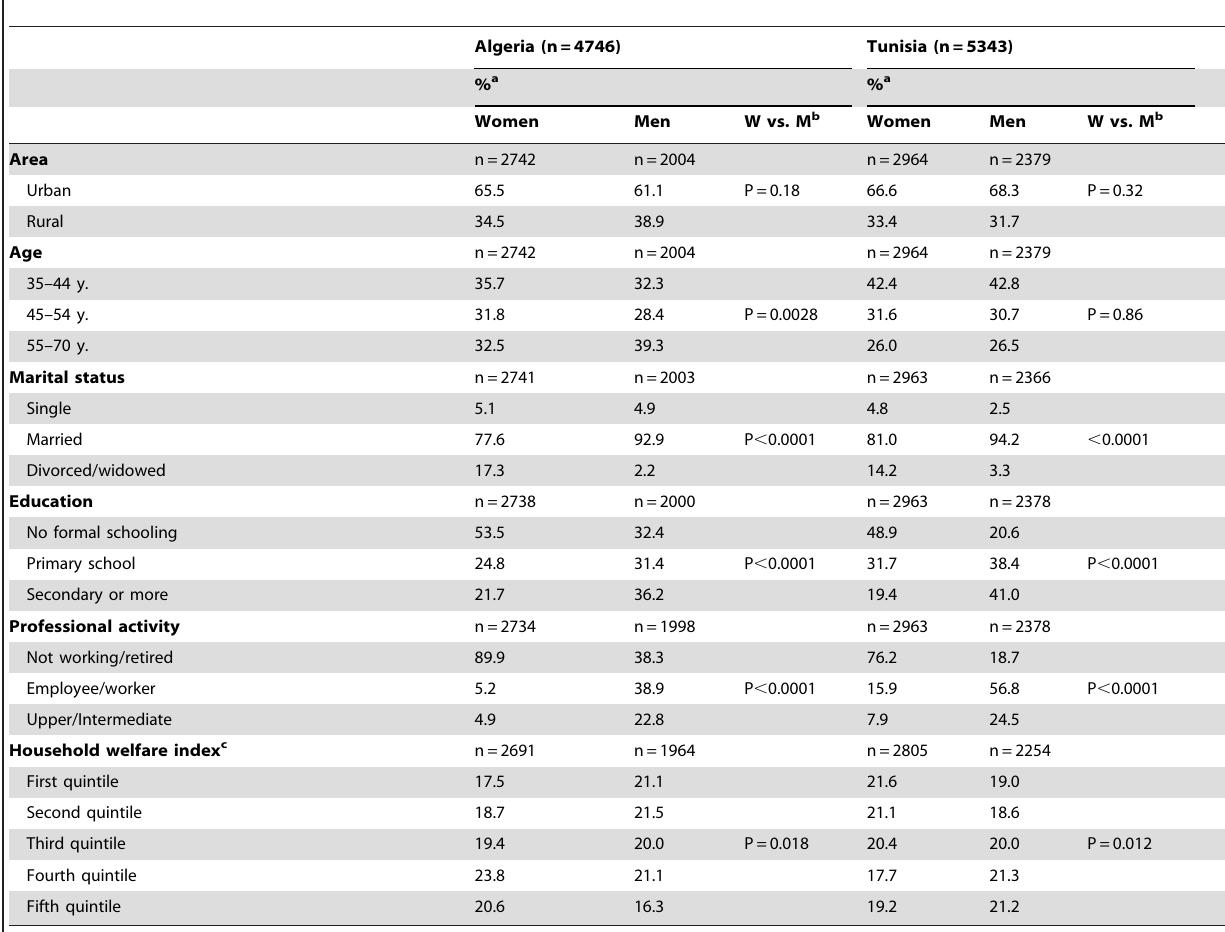
Table 1. Area of residence and socio-economic factors among 35–70 year old Algerian and Tunisian adults, by